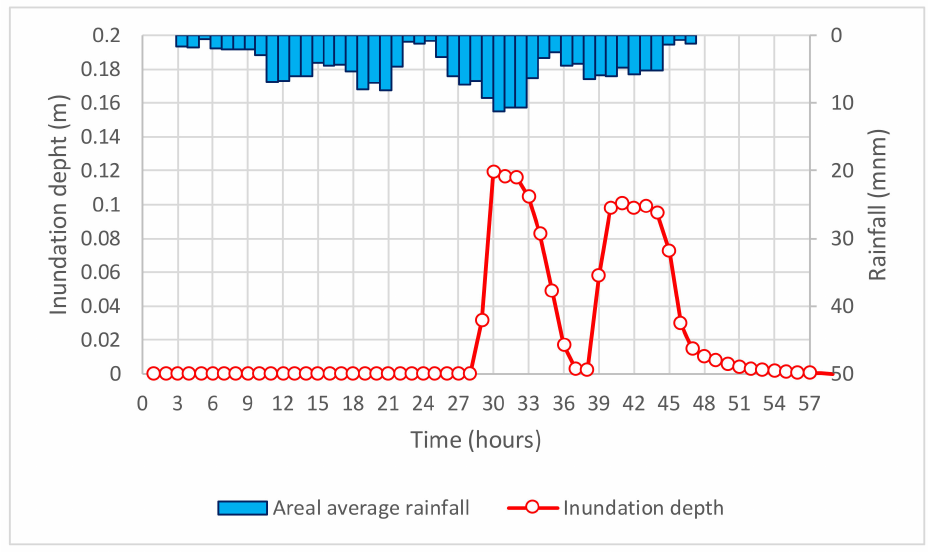
Figure 13. Relationship between the areal average rainfall and inundation depths regarding the 825th validated rainfall-induced flood